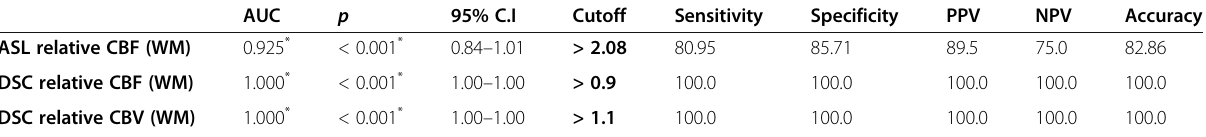
Table 5 Agreement (sensitivity, specificity) for ASL relative CBF (WM), DSC relative CBF (WM), and DSC relative CBV (WM) to differentiate high ( n = 21) from low ( n = 14) grade gliomas